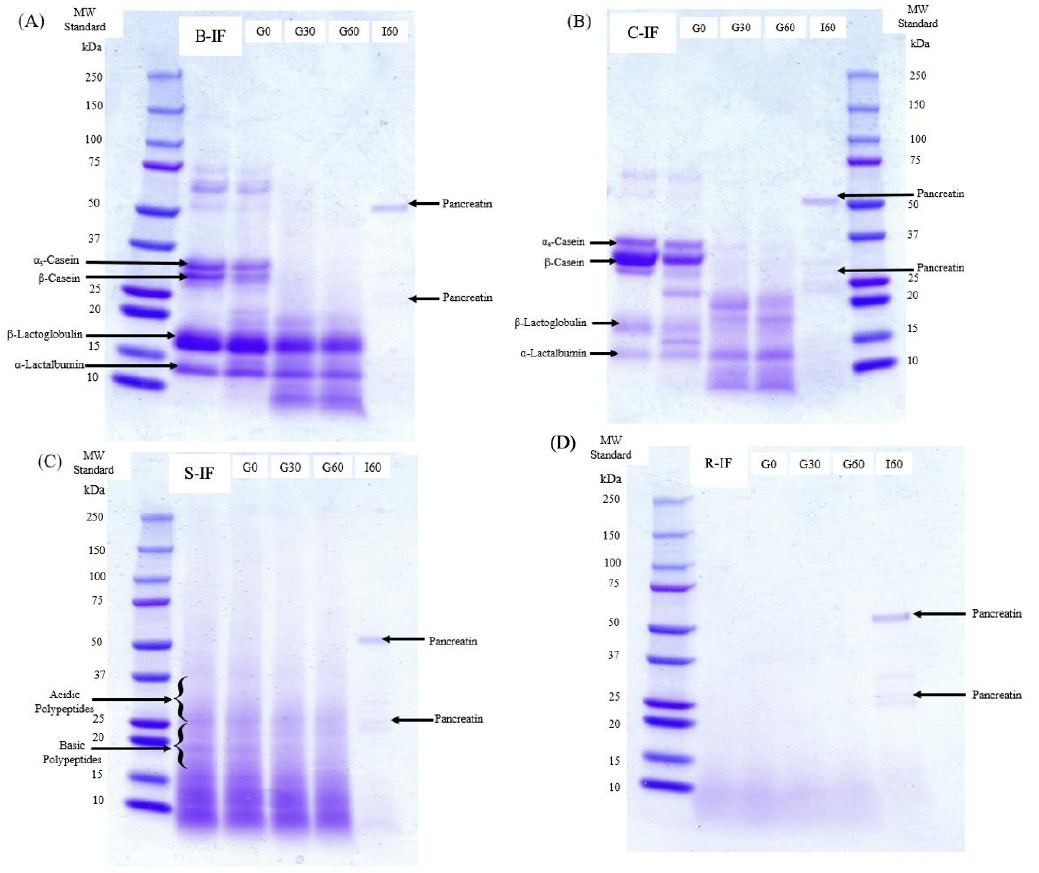
Figure 2. SDS-PAGE electrophoretograms of infant milk formula (IMF) samples displaying reconstituted (undigested) and digested formulae at various gastric (G0, G30, G60) and intestinal (I60) time points. ( A ) B-IF (bovine IF), ( B ) C-IF (caprine IF), ( C ) S-IF (soy IF), and ( D ) R-IF (rice IF).